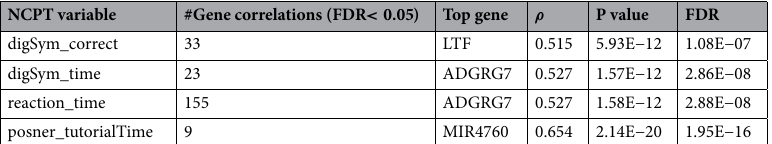
NCPT variable #Gene correlations (FDR < 0.05 ) Top